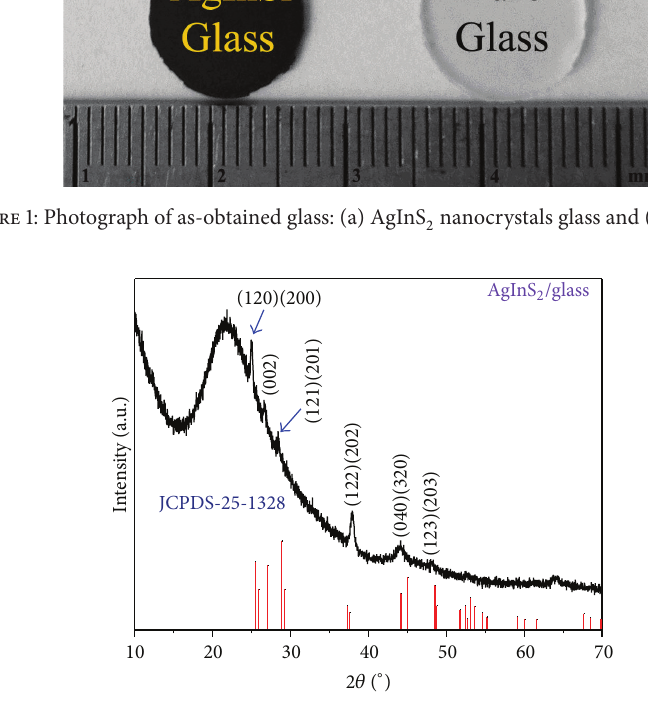
Figure 2 represented an X-ray powder diffraction